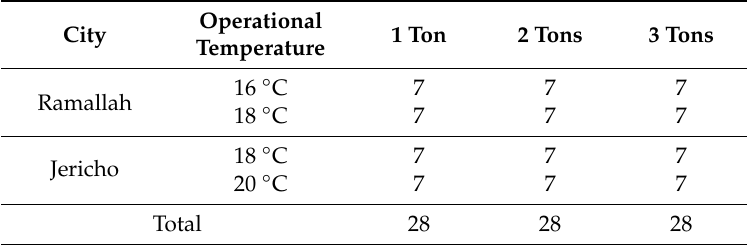
Table 1. Distribution of condensate water quality